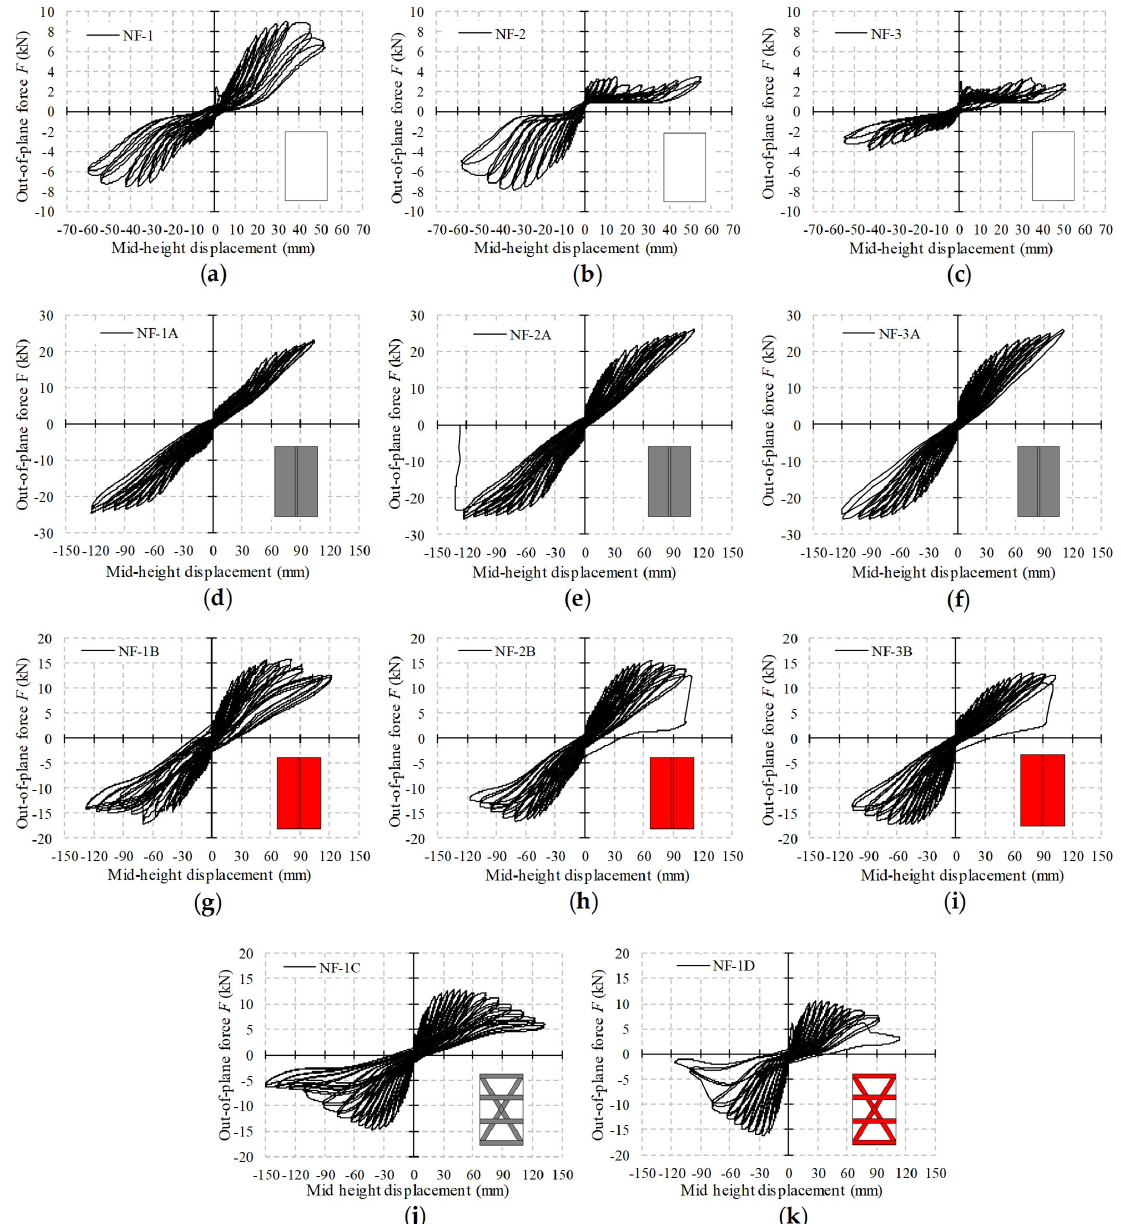
Figure 8. Force–displacement hysteretic responses of: ( a – c ) specimens without strengthening, ( d – f ) with RF stretched over the entire panel, ( g – i ) with RM stretched over the entire panel, ( j ) with reinforcement in the form of RF stripes, and ( k ) with reinforcement in the form of RM